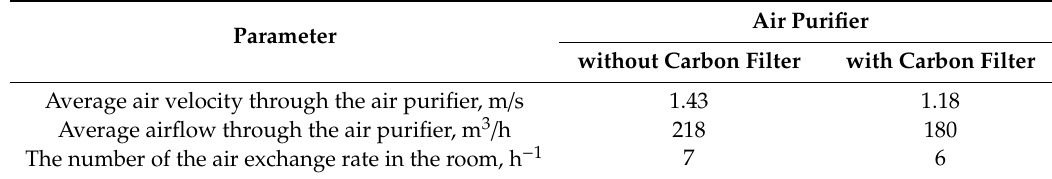
Table 3. Characteristics of air purifiers with and without carbon filter.